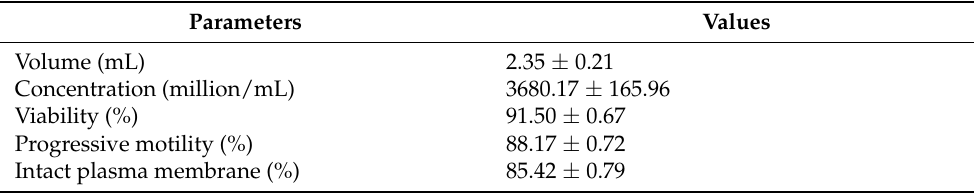
Table 1. The parameters of Kacang buck semen.